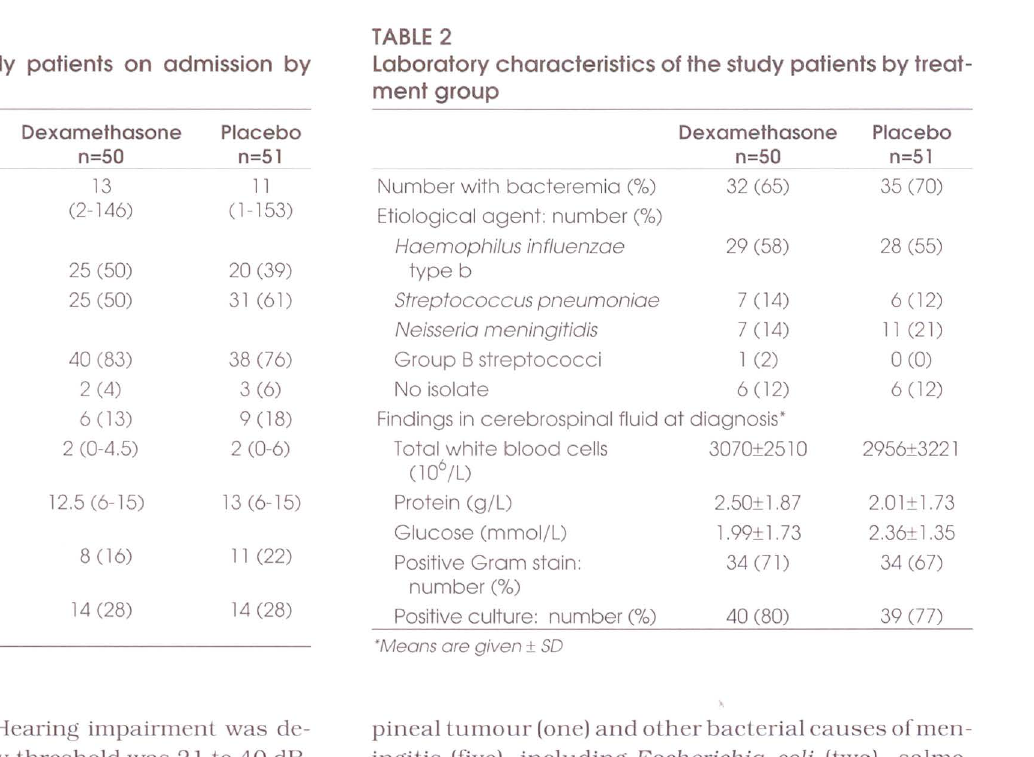
Characteristics of the study patients on admission by treatment